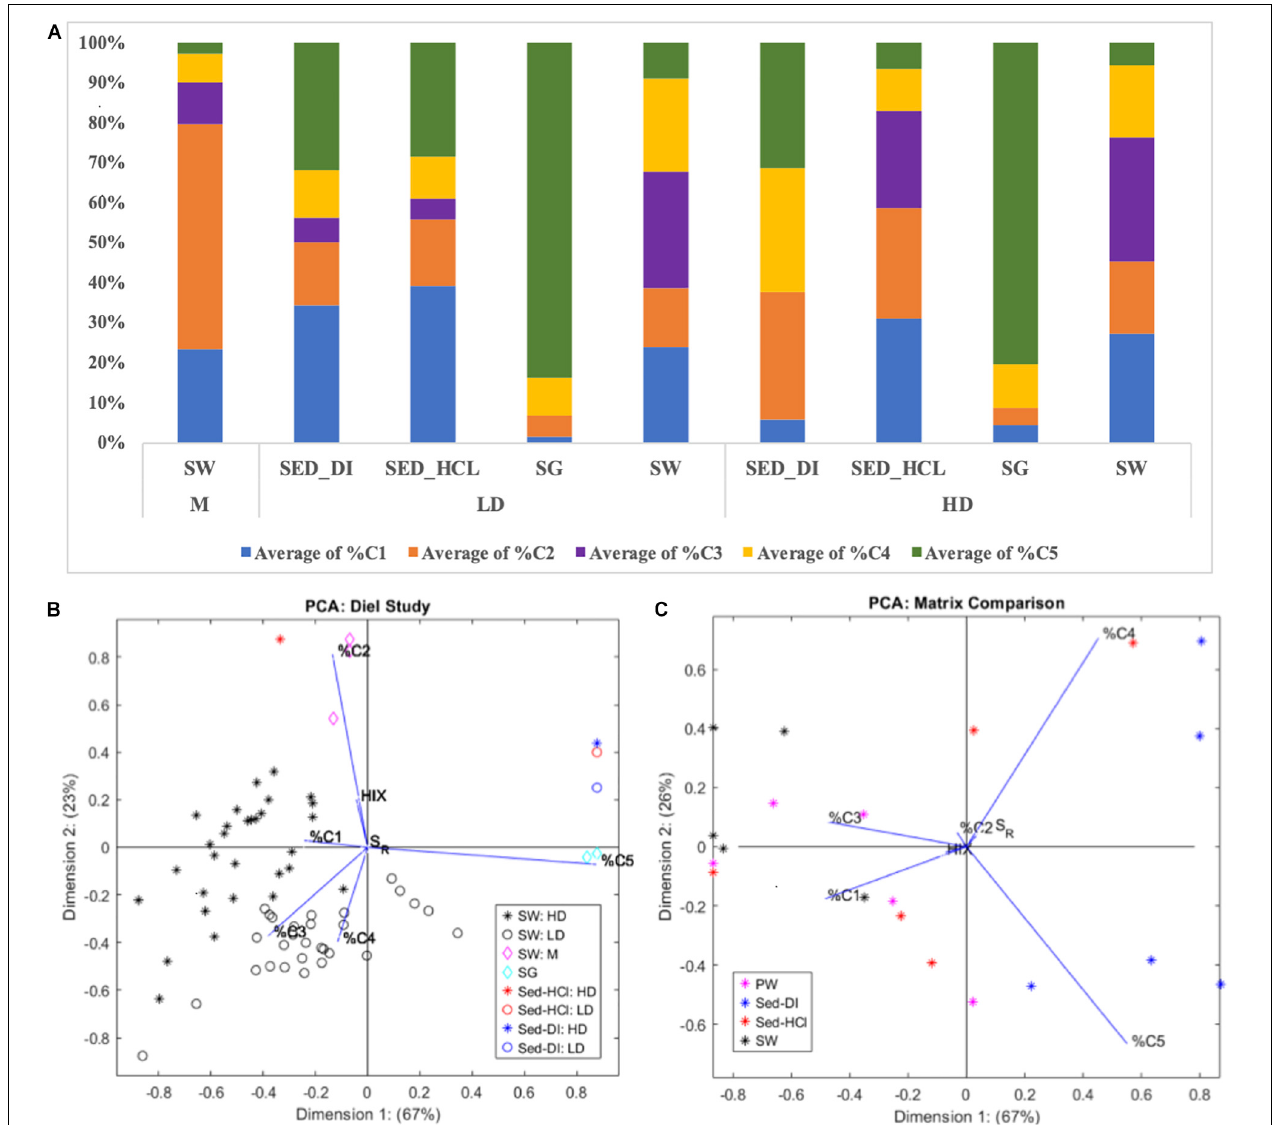
FIGURE 3 | (A) PARAFAC component makeup of the different matrixes (SW, SG, SED DI , and SED HCl ) from the HD and LD sites, compared to the nearby Mangrove (M) site. (B) PCA of the data shown in the top figure, from the diel portion of this study. (C) PCA of the data from the five additional sites throughout FB, separated by matrix (PW, SW, SED DI , and SED HCl